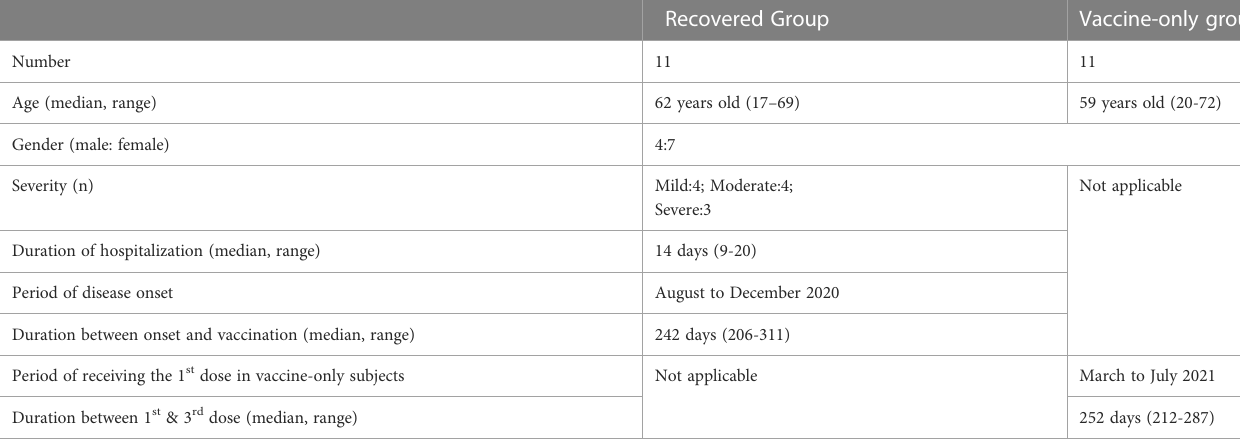
TABLE 1 Demographics of the recovered patients and vaccine-only